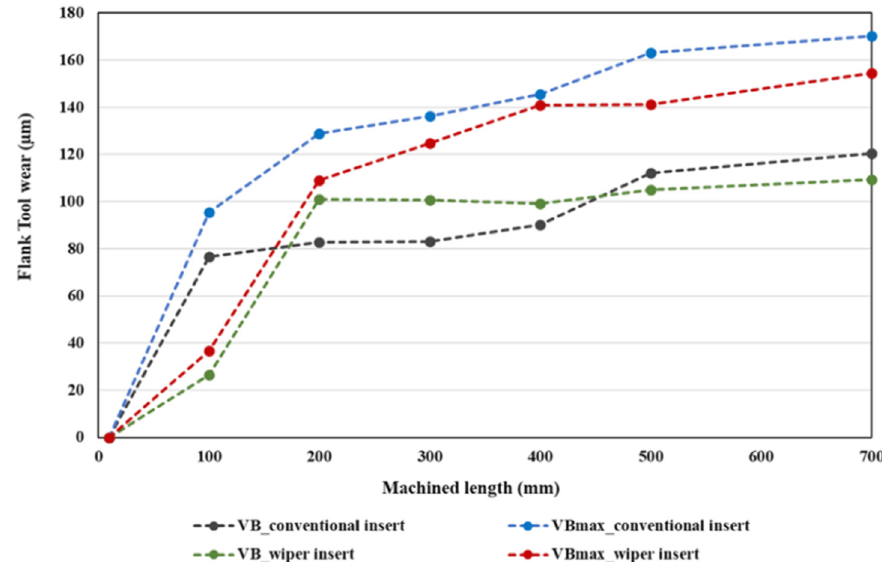
Figure 5. Average (VB) and maximum (VB max ) flank wear for the conventional and wiper inserts for a range of machined lengths of AISI 4340.